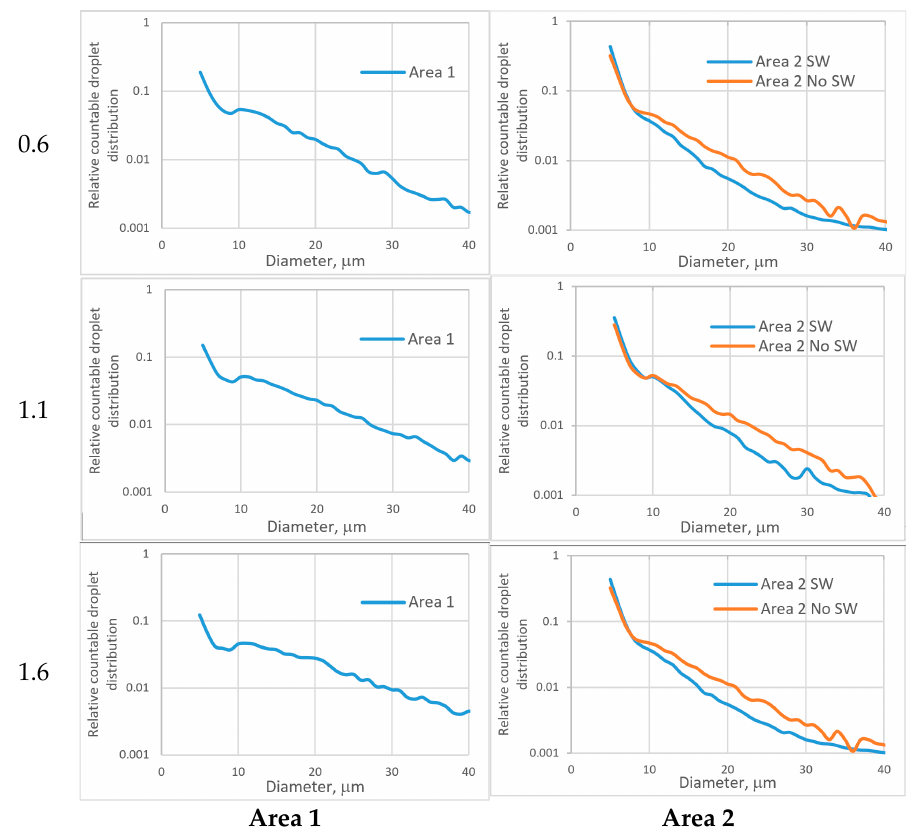
Figure A1. Relative countable droplet distribution by diameters, gas flow Mach number M = 2. The left column shown water injection pressure p l , MPa.